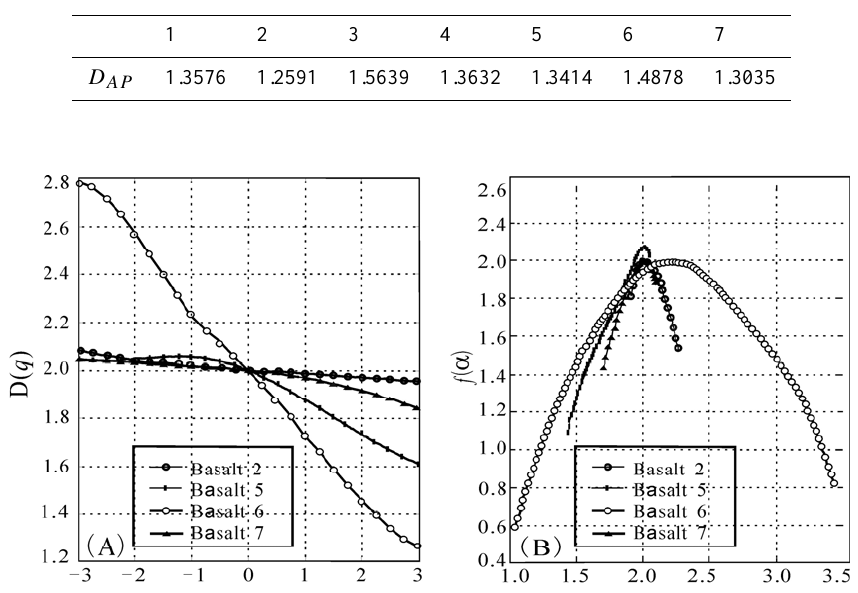
Fig.3. Multifractal analysis results. ( a ) Estimation of the spectra of generalized fractal dimensions when -3< q <3 for the mineral distribution patterns in the thin sections from the basalt samples of the second, the fifth, the sixth and the seventh segment, respectively. The D ( q ) in the calculated spectra have been obtained with regression fits where the determination coefficient R 2 is higher than 0.955. ( b ) Multifractal spectra for the spatial distribution patterns of pyrrhotite particles.